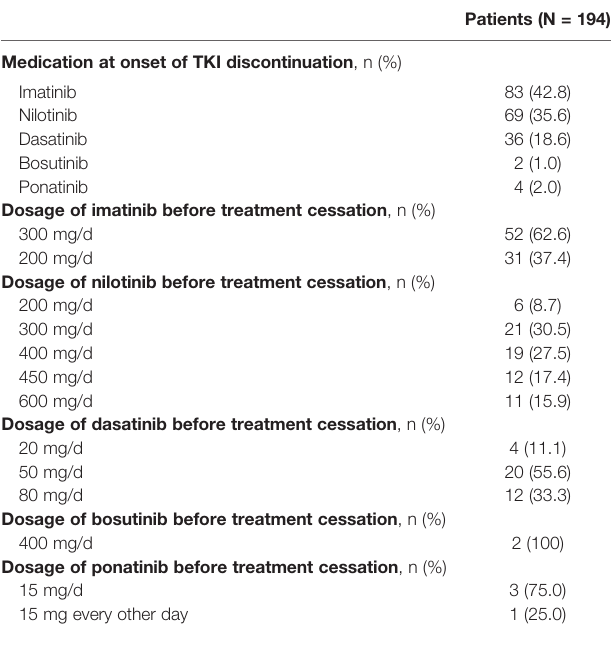
TABLE 3 | Treatment characteristics.